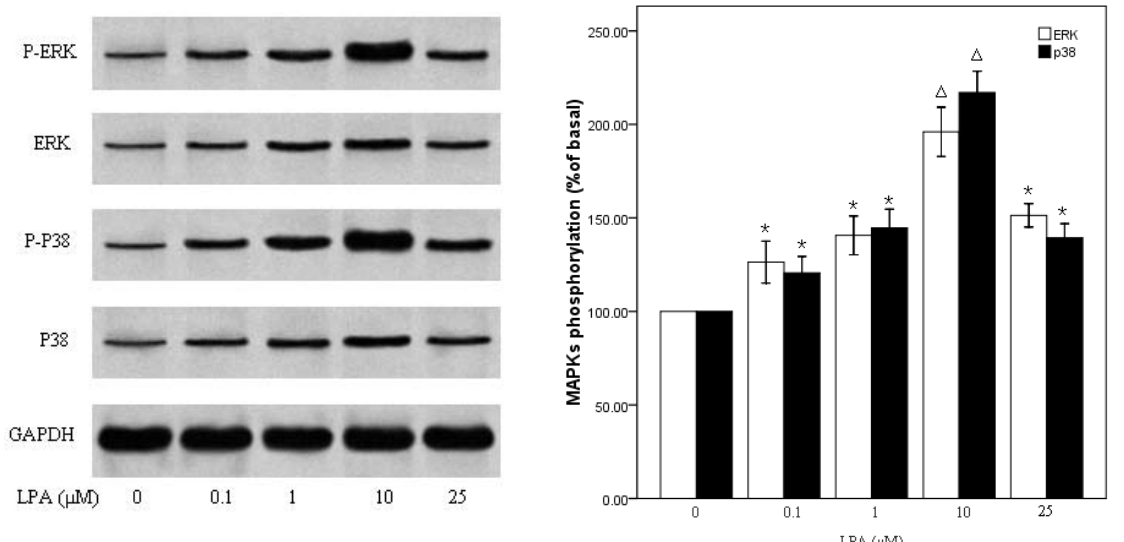
Figure 4. LPA induced phosphorylation of p38 MAPK and